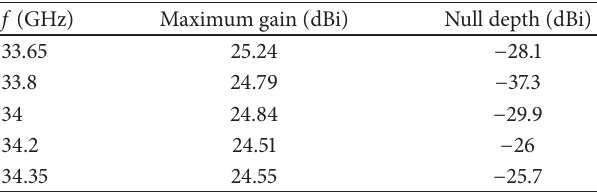
Table 2: Measured maximum gains and the null depths at different